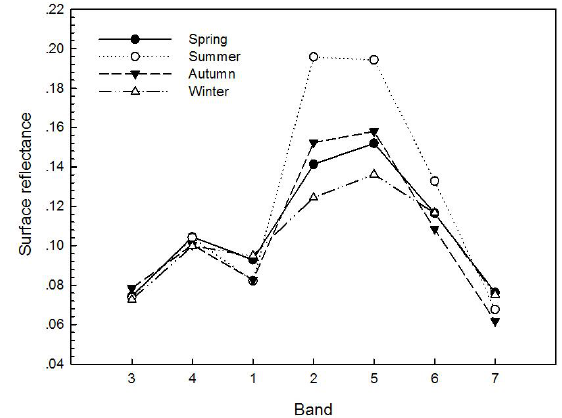
Figure 2. Variation of surface reflectance as recorded in the seven MODIS wavebands in four seasons.